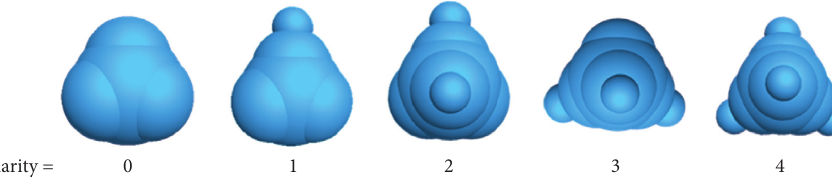
Figure 10: Idealized shaped clump used to represent the angular